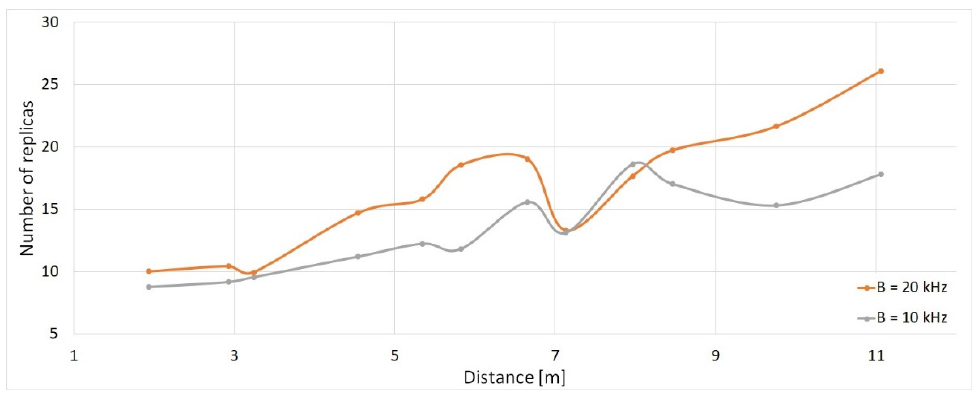
Figure 11. Comparison of the number of replicas as a function of the distance between the transmitter ter and the receiver for different chirp bandwidths, 𝐵 . and the receiver for different chirp bandwidths, B